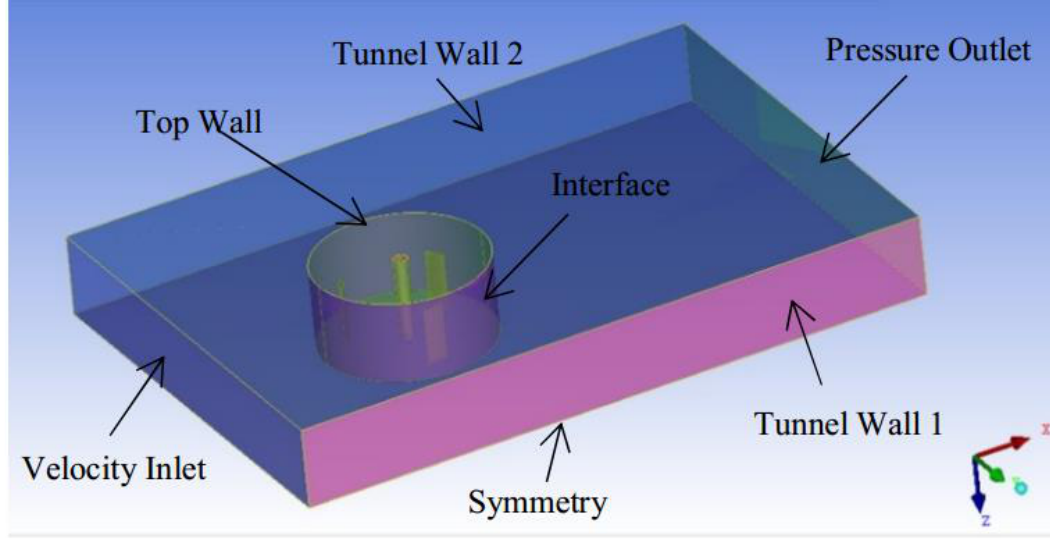
Figure 4. Nomenclature of the computational domain.